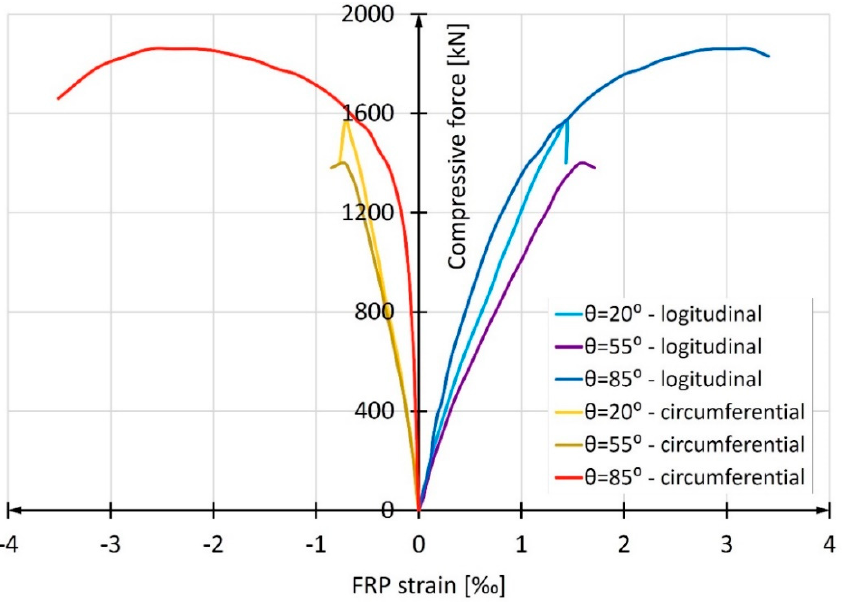
Figure 16. The development of average deformations in the long CFFT columns with different fiber winding angles.